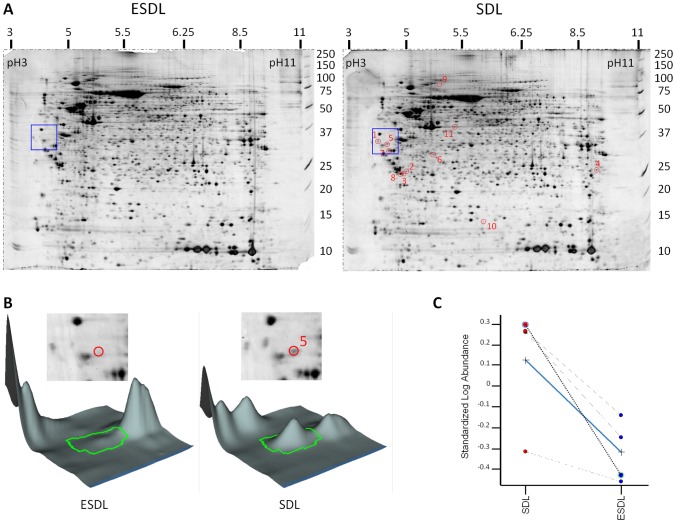
2D gels and spots identified after Epo removal.(A) 2D gel analysis of total cell lysates harvested after 12 hour in ESDL (+Epo) and SDL (-Epo). The 11 spots circled on the SDL 2D gel (right gel) were found to be consistently up-regulated in SDL (change of average ratio >2, t-test of p<0.05) when comparing the four SDL with the four ESDL 2D gels. These 11 spots are described in Table 1. The blue square depicts the region of the gel shown in Figure 3B. (B) Typical example of a protein differentially represented in the 2 culture conditions, ESDL and SDL. 3D views of spot 5 in Figure 3A and identified by mass spectrometry as a proteolytic fragment of Hsp90 alpha (see Table 1). The difference in intensity of spot 5 on one SDL and one ESDL gel is visible by eye on the 2D gels (spot marked with the red boundary) and on the corresponding 3D views. (C) Example graph showing the amount of protein for spot 5 in all 8 gels (4 SDL gels and 4 ESDL gels), together with the average ratios linked by the blue line.